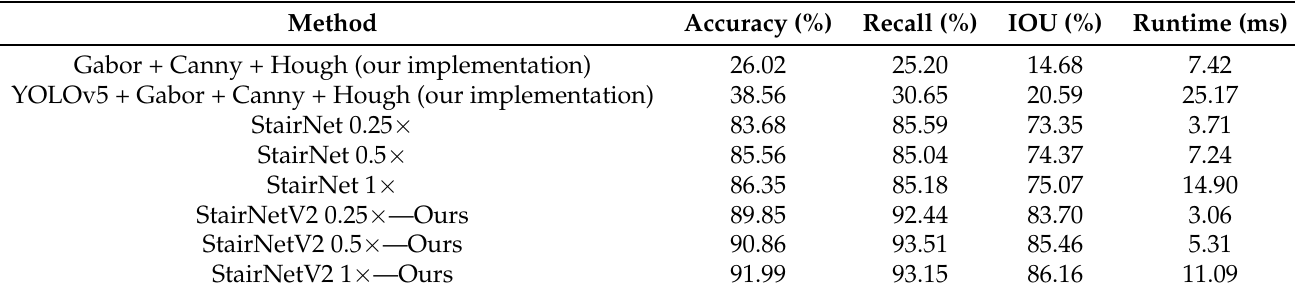
Table 6. Comparison experiment